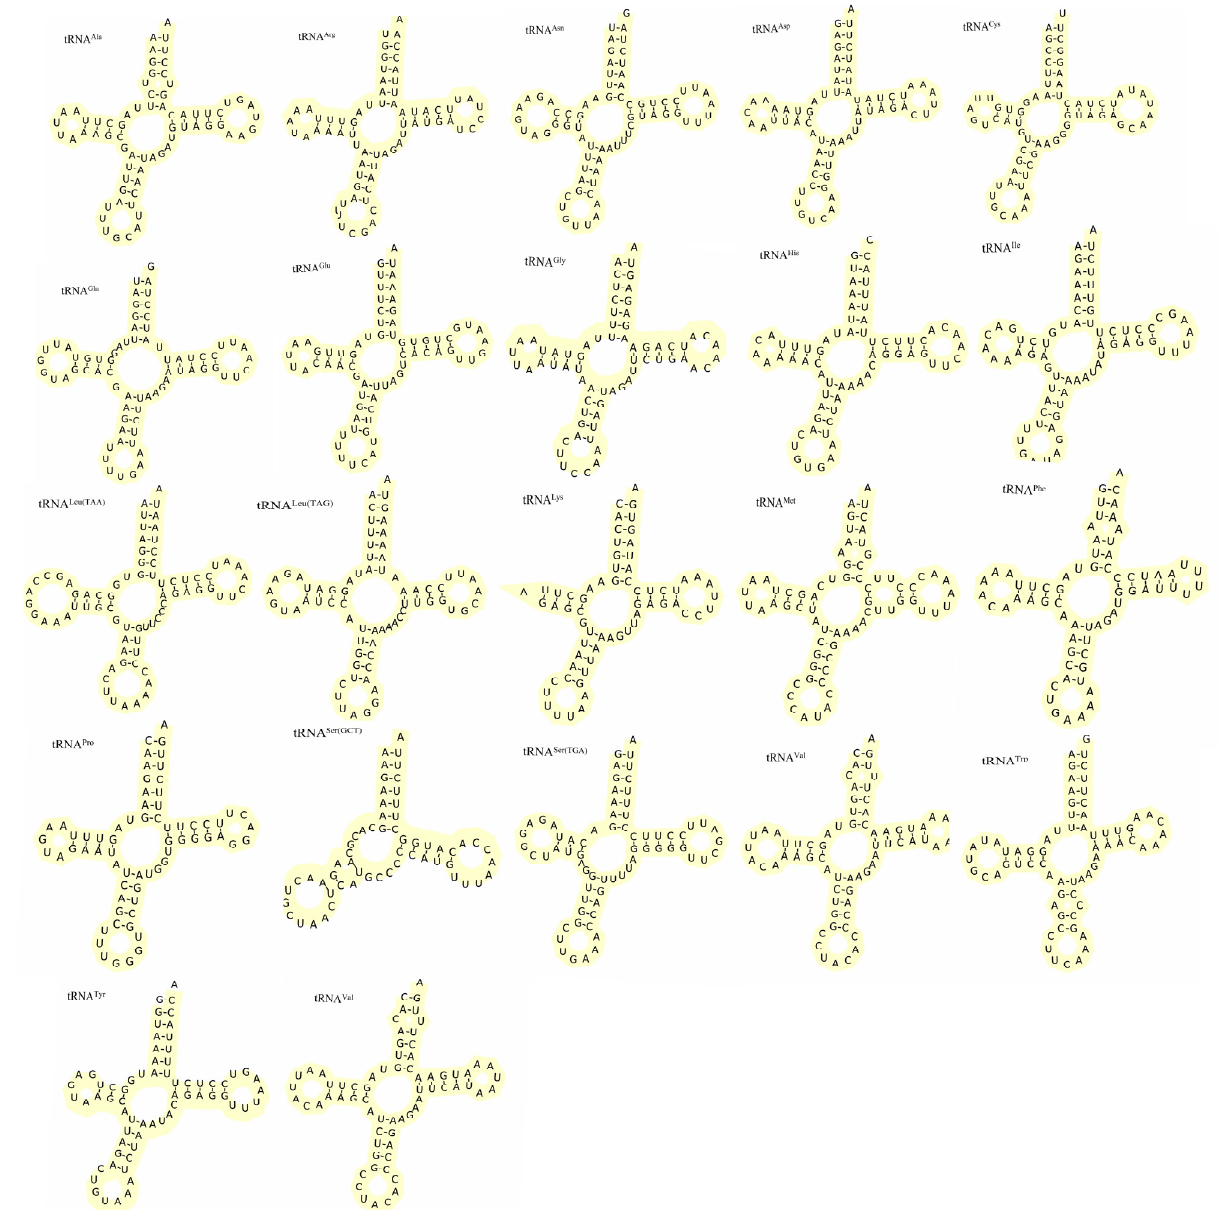
Figure 6. Structures of tRNA of Apodemus agrarius ningpoensis .